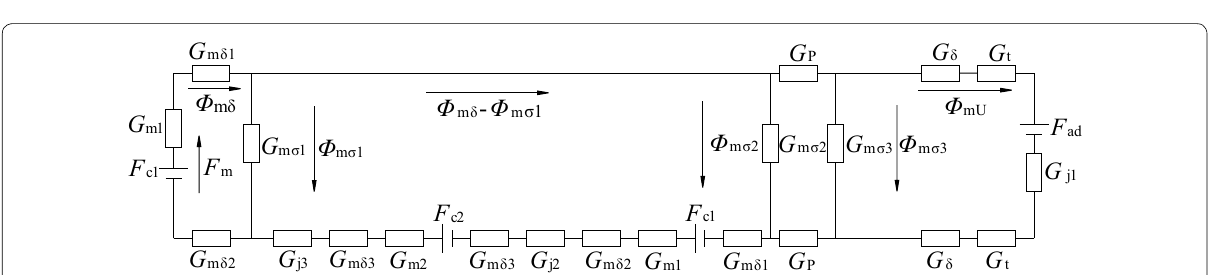
Figure 10 The equivalent magnetic circuit diagram of double-radial permanent magnet part